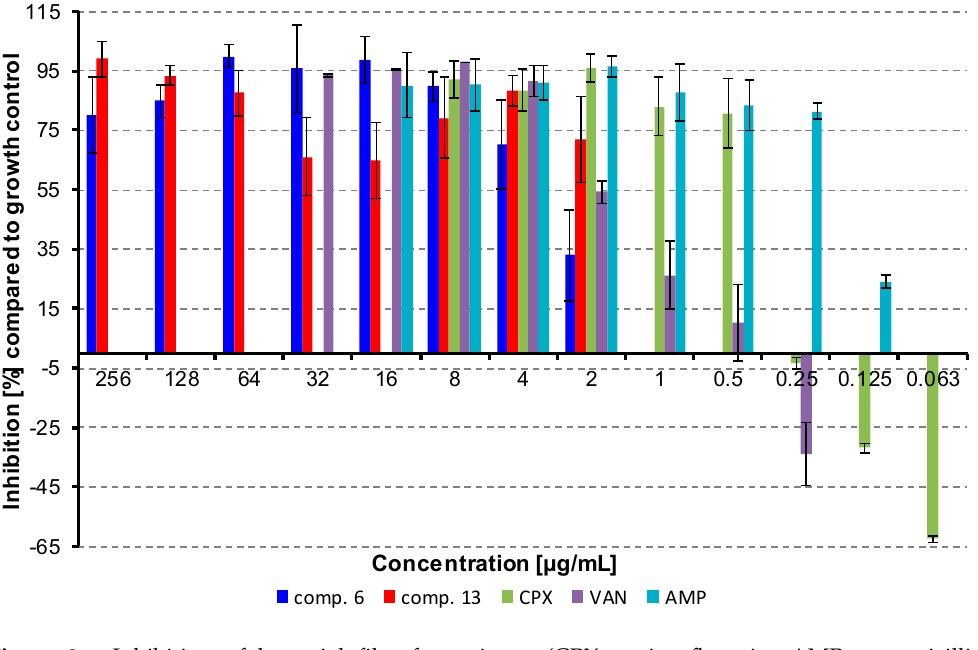
Figure 3. Inhibition of bacterial film formation. (CPX = ciprofloxacin, AMP = ampicillin, VAN = vancomycin).